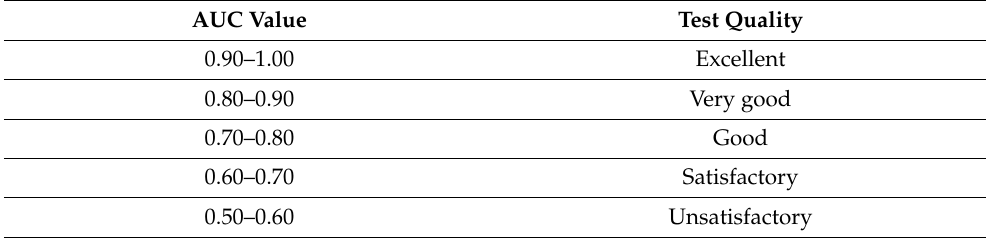
Table 4. The expert scale for AUC values shows the quality of the